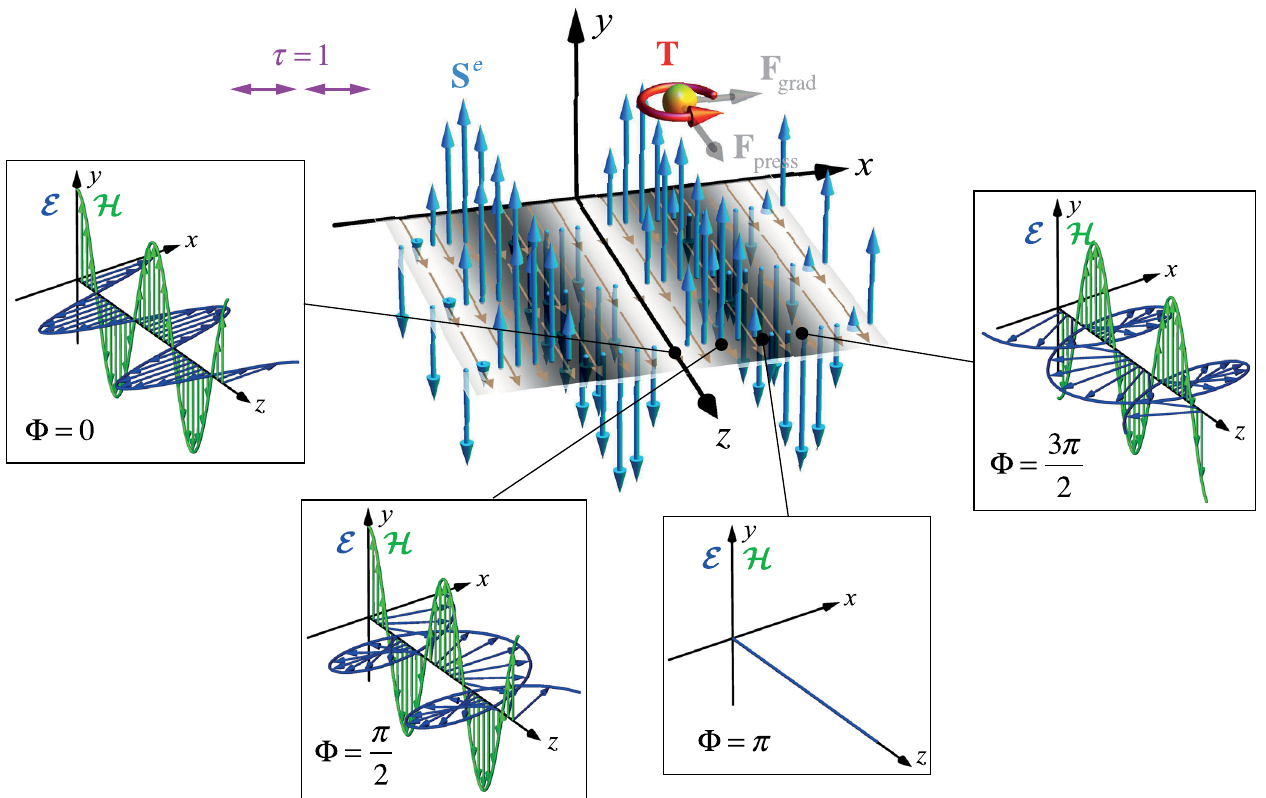
FIG. 2. Transverse helicity-independent spin in the two-wave interference field. Distribution of the electric spin AM density [Eq. (11)] S e ð x Þ is shown here for the simplest case of linearly in-plane polarized waves, m 0 , i.e., the Stokes parameters ð τ ; χ ; σ Þ ¼ 1 ¼ m 2 ¼ ð 1 ; 0 ; 0 Þ (shown schematically in purple). Despite the seemingly ð x; z Þ -planar character of the problem without any helicity, the transverse y -directed spin AM density appears. The inset panels display instantaneous electric and magnetic field distributions, E ð r ; 0 Þ and H ð r ; 0 Þ , as functions of z at different x positions, indicated by the values of the phase Φ ¼ 2 kx sin γ . These distributions show that the transverse spin arises from the cycloidlike in-plane distribution of the electric field (cf. the evanescent-wave case [9 – 12]) with the direction of rotation dependent on Φ . An absorbing probe particle is shown here at the position corresponding to Φ ¼ π = 2 , and the optical forces and torques are indicated schematically. The transverse spin AM is locally transferred to the particle, thereby exerting a radiation torque [Eq. (15)] T ∝ S e (shown in red) (see Fig. 4 for numerical simulations). The particle also experiences in-plane radiation- pressure and gradient forces [Eq. (14)] [shown in